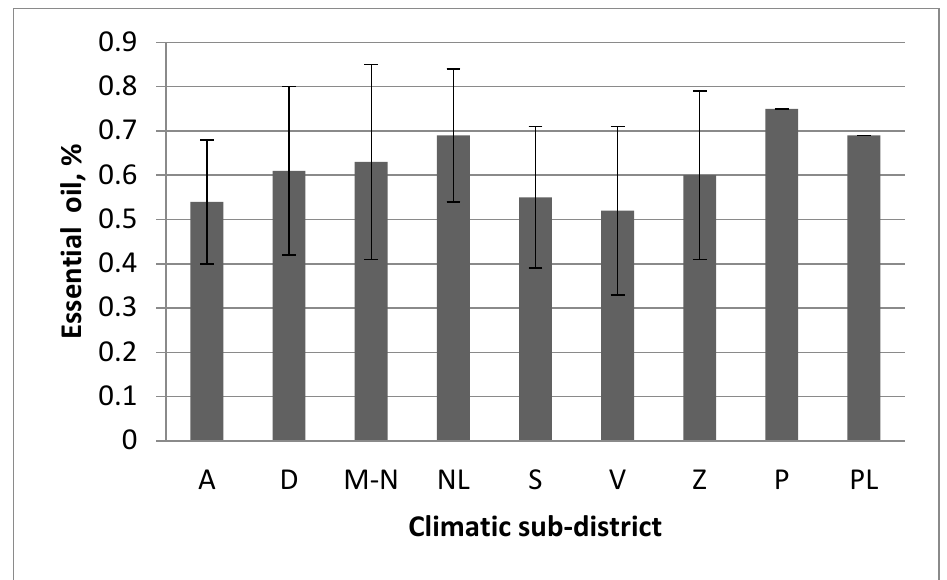
Figure 2. Two dimensional dendrogram of Thymus pulegioides habitats by chemotypes determining the main chemical compounds of essential oils.